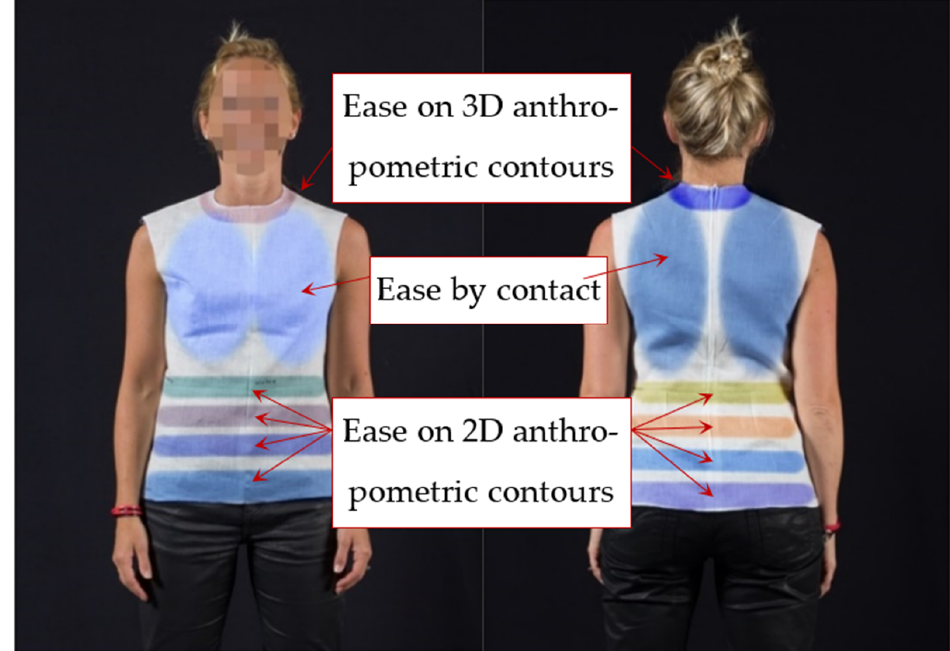
Figure 4. Ease allowance managed by zone.